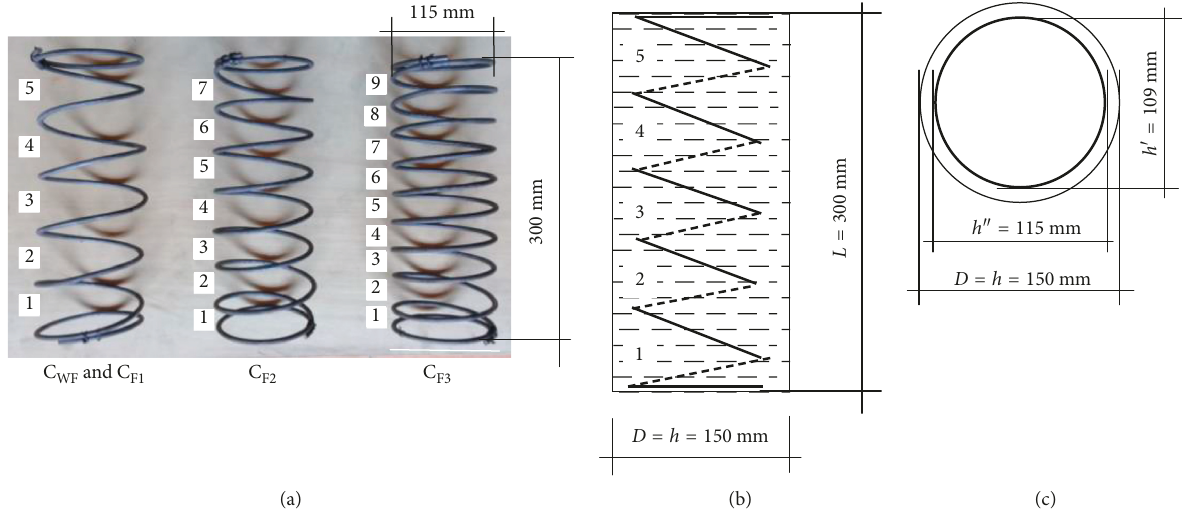
Figure 2: Details of spiral and specimens: (a) details of spiral, (b) dimensions of spirally confined specimens, and (c) cross section of specimens. Table 2: Details of test specimens.